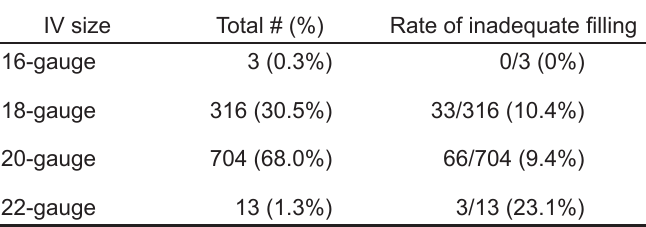
Table 3. Intravenous (IV) catheter size and rate of inadequate pulmonary vasculature